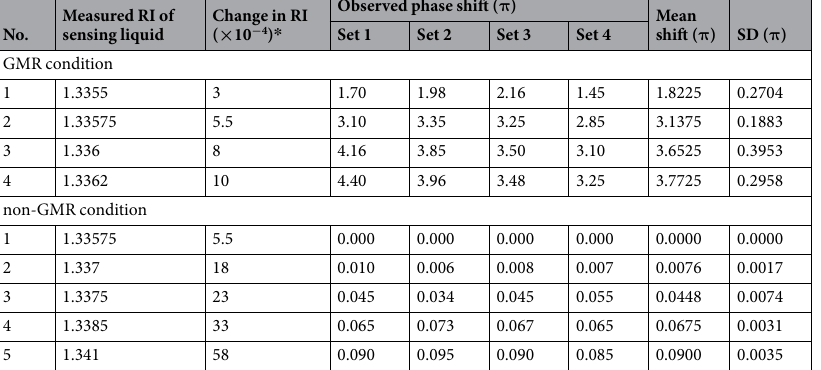
Table 1. Experimentally measured phase change with respect to refractive index change for both GMR & non- GMR position. * The measured changes are with respect to the reference DI water of RI